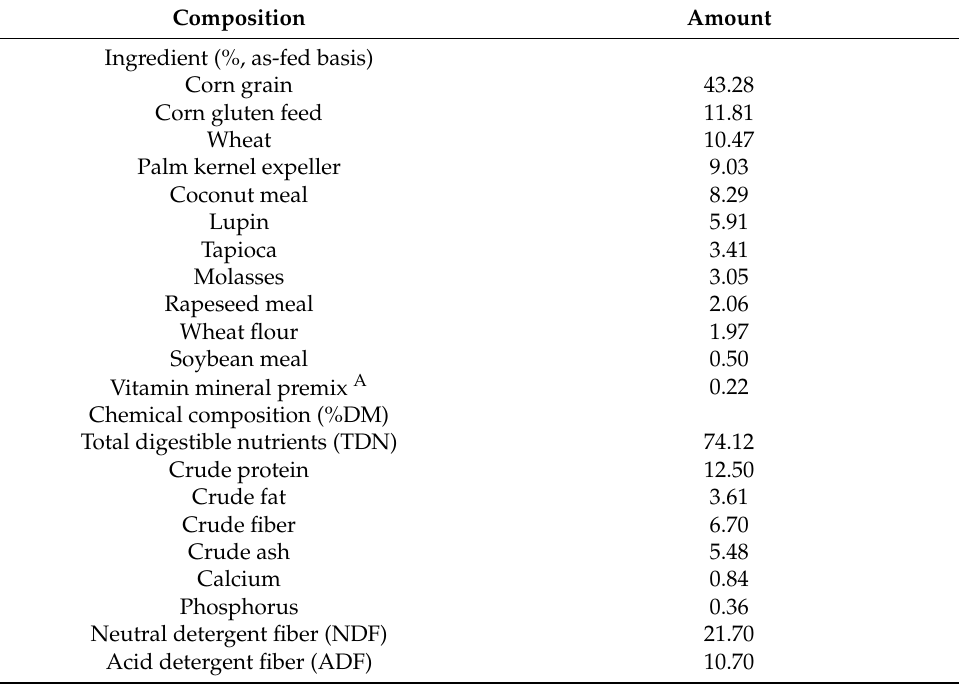
Table 1. Feed ingredients and chemical composition of experimental diet for Hanwoo